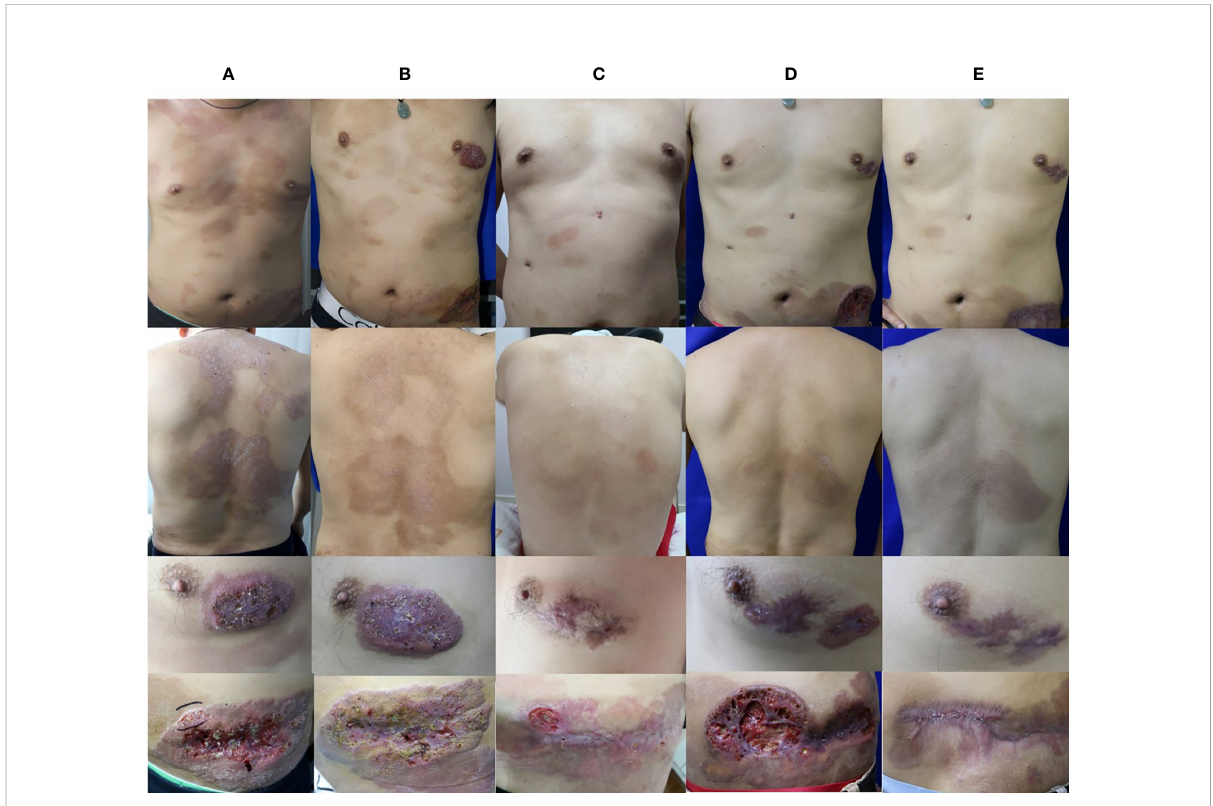
FIGURE 1 Clinical image. (A) Skin lesions of the patient during the initial visit. (B) Skin lesions of the patient after 4 months of oral terbina fi ne and itraconazole treatment. (C) Skin lesions of the patient after 15 months of combination treatment with oral terbina fi ne, itraconazole, and ALA-PDT. (D) Skin lesions of the patient after 14 months of oral voriconazole. (E) Skin lesions of the patient after 4 months of oral